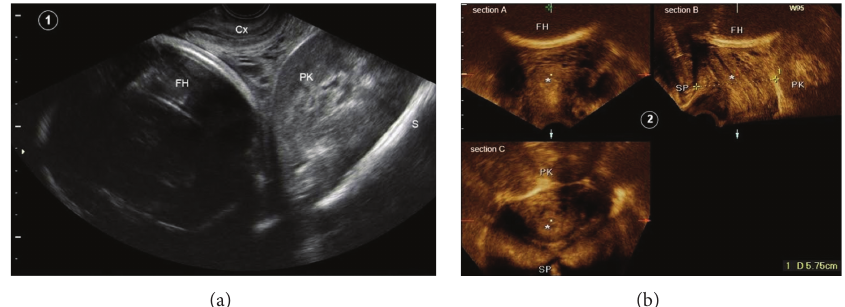
Figure 2: Transvaginal sonograms performed before cesarean section. (a) shows a sagittal B-mode sonogram of the maternal pelvis. The pelvic kidney (PK) is located between the sacral wall (S) and uterine cervix (Cx). The fetal head (FH) is positioned above the kidney and cervix. A three-dimensional multiplanar reformatted sonogram of the maternal pelvis is demonstrated in (b). The 3D volume was obtained by the sagittal acquisition using Voluson E8 ultrasound machine (GE Healthcare) and transvaginal probe (RIC 5-9H/OB). The maternal pelvis is orientated in three orthogonal planes: the coronal plane in section A; the median plane (section B) showing the cervix ( ∗ ) and fetal head (FH); and the axial plane in section C. Symphysis pubis (SP) and pelvic kidney (PK) appear in the left and right sides of section B, correspondingly. The internal edge of SP and the anterior margin of PK are indicated by the white arrowheads and small white arrows, respectively. The anteroposterior diameter of the pelvic canal between SP and PK was only 5.75 cm. Similarly, in the axial plane (section C) the pelvic canal shows a deformed shape due to the bulging of the pelvic